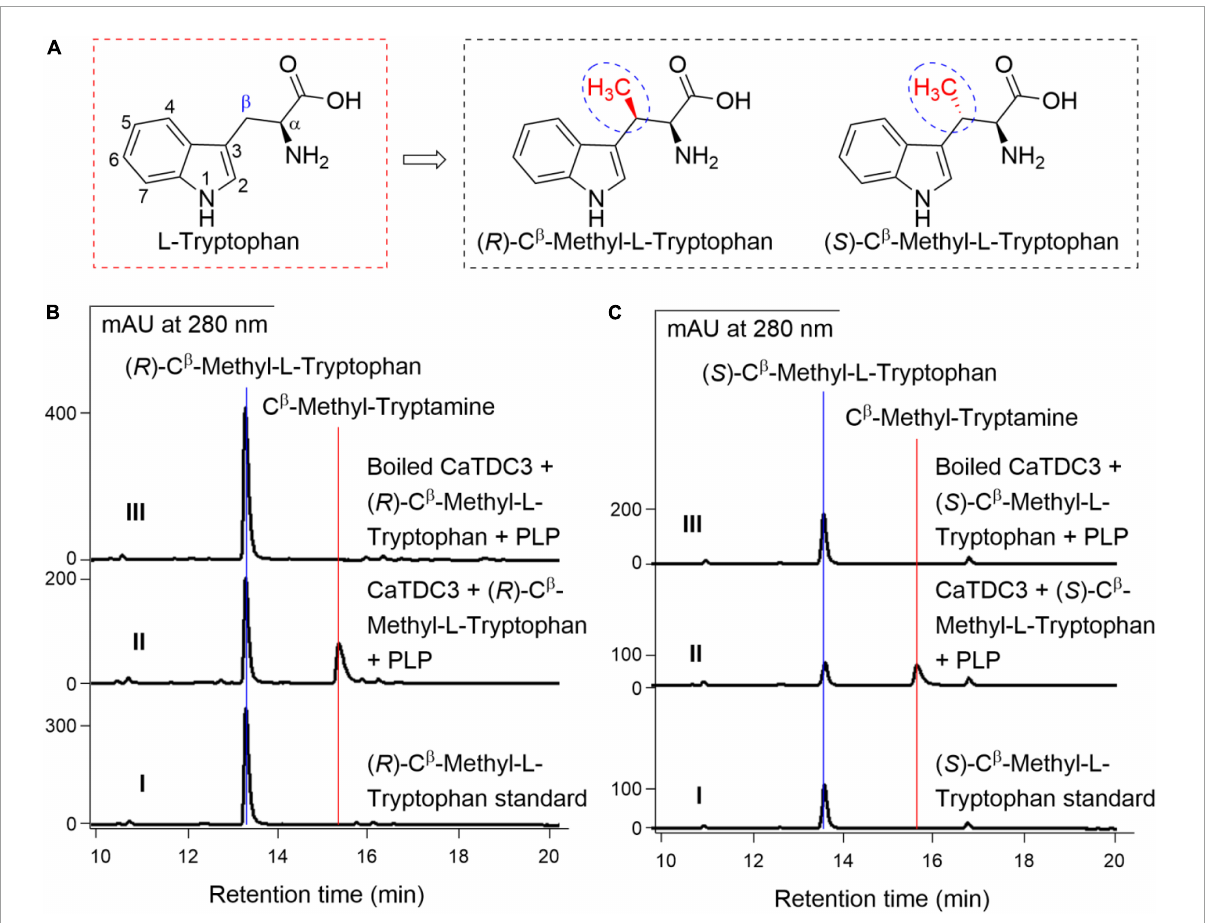
FIGURE9 The effects of substituent groups at C β of L-tryptophan on CaTDC3’s decarboxylative activity. Chemical structure of ( R )-C β -methyl- and ( S )-C β -methyl-L-tryptophans tested in the present work (A) . (B) HPLC-DAD analyses of the standard ( R )-C β -methyl-L-tryptophan (panel I), the enzymatic reaction mixture with CaTDC3 (panel II), and boiled CaTDC3 (panel III) as catalyst, respectively. (C) HPLC-DAD analyses of the standard ( S )-C β -methyl-L-tryptophan (panel I), the enzymatic reaction mixture with CaTDC3 (panel II), and boiled CaTDC3 ( panel II) as catalyst,